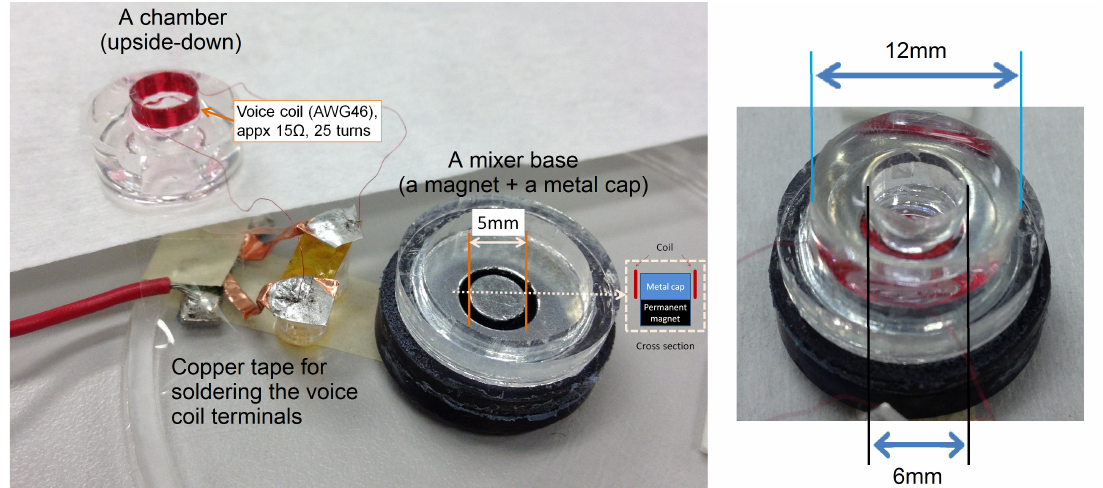
Figure 2. The electromagnetic mixer design. A voice coil is attached to a PDMS-based membrane. A hollow, cylindrical chamber is connected to form a mixer unit. Input signals are driving from the electrical terminals (two ends of the voice coil), and loads vary in mechanical terminals. As shown in the previous study [17], the mechanical loads’ variation, including mixing performance, can be captured at the electrical input